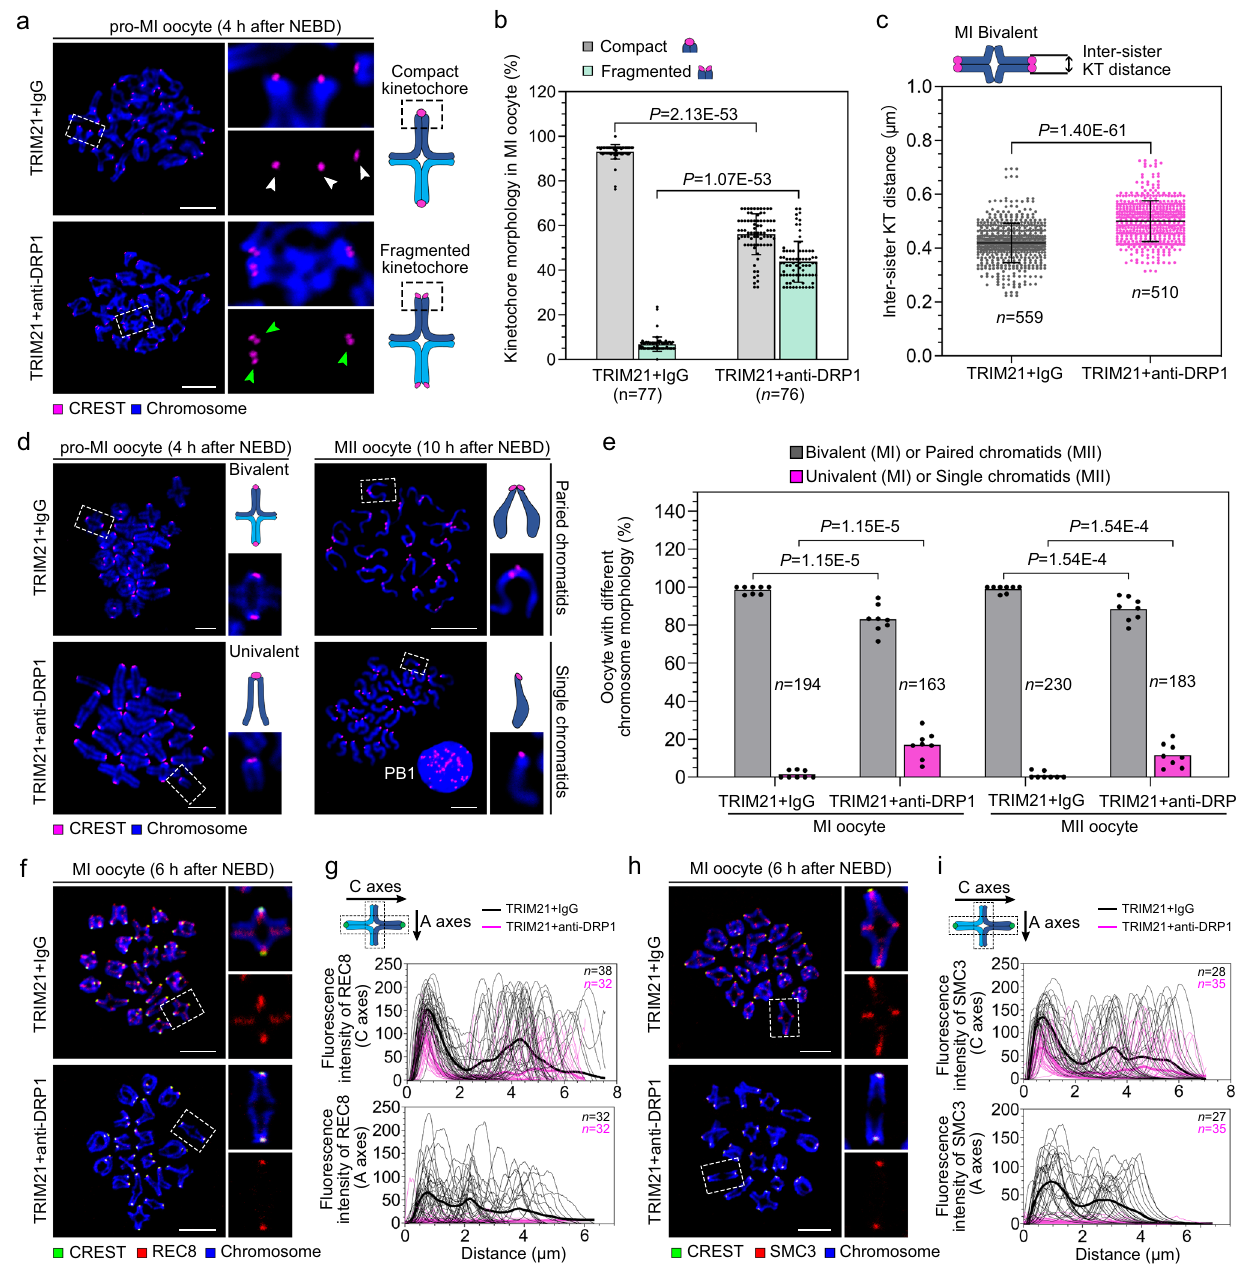
Fig.3|DRP1lossleadstoSACdefectsandprematurechromosomeseparation. a Kinetochorecon fi gurationsincontrolorDRP1nulloocytes.Whitearrowsindicate the compact kinetochores, and green arrows indicate the fragmented kine- tochores. b The occurrence frequency of kinetochore morphology in ( a ) in three independent replicates. c Measurement of inter-sister kinetochore distance of MI bivalents in ( a ). Three independent replicates were performed. d Chromosome con fi gurations of control or DRP1 null oocytes at MI and MII stages. Enlarged images show representative chromosomes. e The occurrence frequency of chro- mosome morphology in ( d ) in eight independent replicates. f MI stage oocyte microinjected with TRIM21+IgG or TRIM21+anti-DRP1 were stained for REC8 (red). Enlarged images show representative results. g Fluorescence intensity of REC8oncentromericarms( C axes)andacentricarms( A axes)in( f )wasmeasured, respectively. Three independent replicates were performed. h MI stage oocytes microinjected with TRIM21+IgG or TRIM21+anti-DRP1 were stained for SMC3